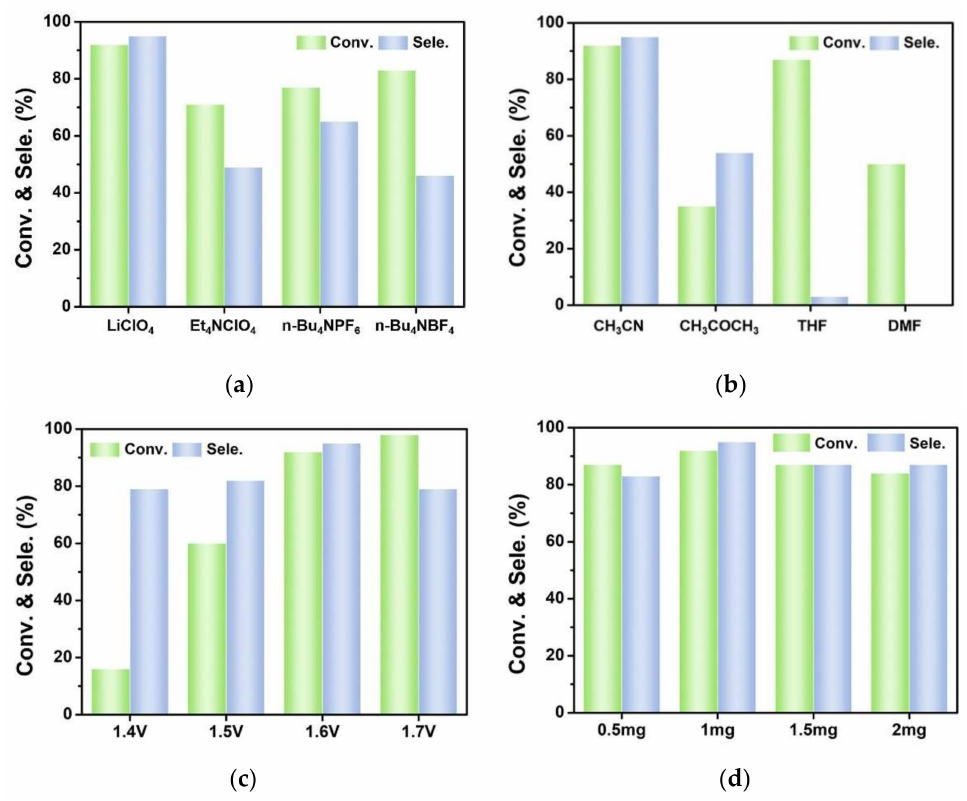
Figure 6. The influence of supporting electrolytes ( a ), solvent ( b ), applied potential ( c ), and catalyst dosage ( d ) on the electrocatalytic oxidation of BA by 1 .